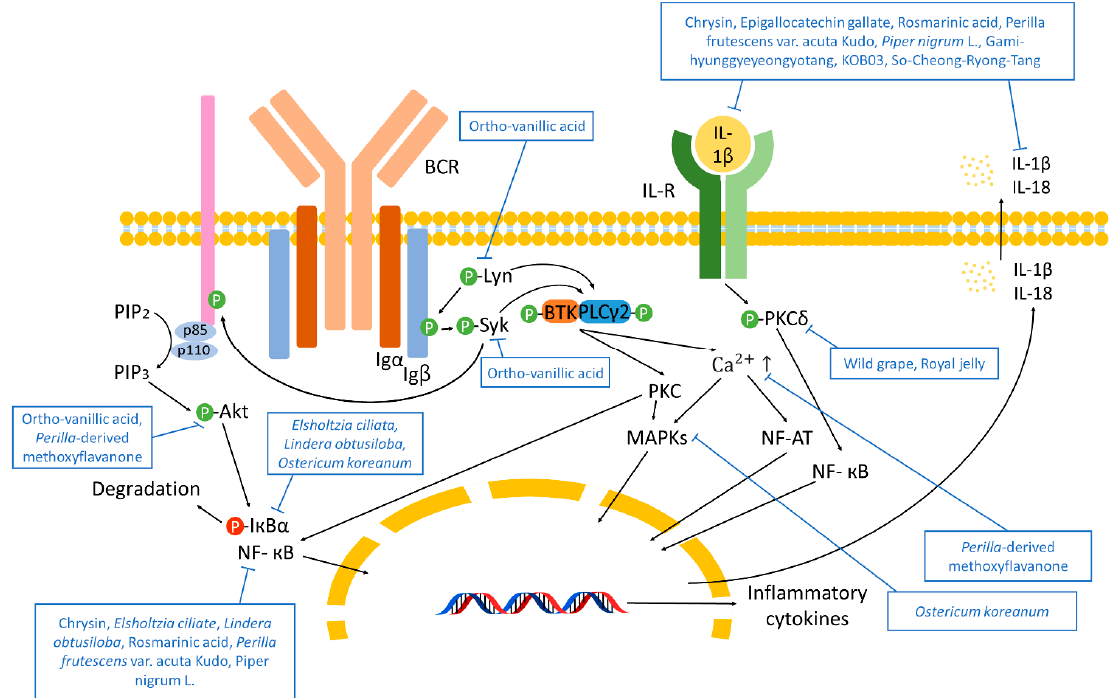
Figure 5. Various pathways for immune response. PIP 2 , phosphatidyl inositol 4, 5-trisphosphate; PIP 3 , phosphatidylinositol 3, 4, 5-trisphosphate; P, phosphate; NF- κ B, p65 nuclear factor kappa B; BCR, B cell receptor; Ig, immunoglobulin; Syk, spleen tyrosine kinase; BKT, Bruton’s tyrosine kinase; PLC γ 2, phospholipase C gamma 2; IL, interleukin; IL-R, interleukin receptor; MAPK, mitogen-activated protein kinase; NF-AT, nuclear factor of activated T-cells.